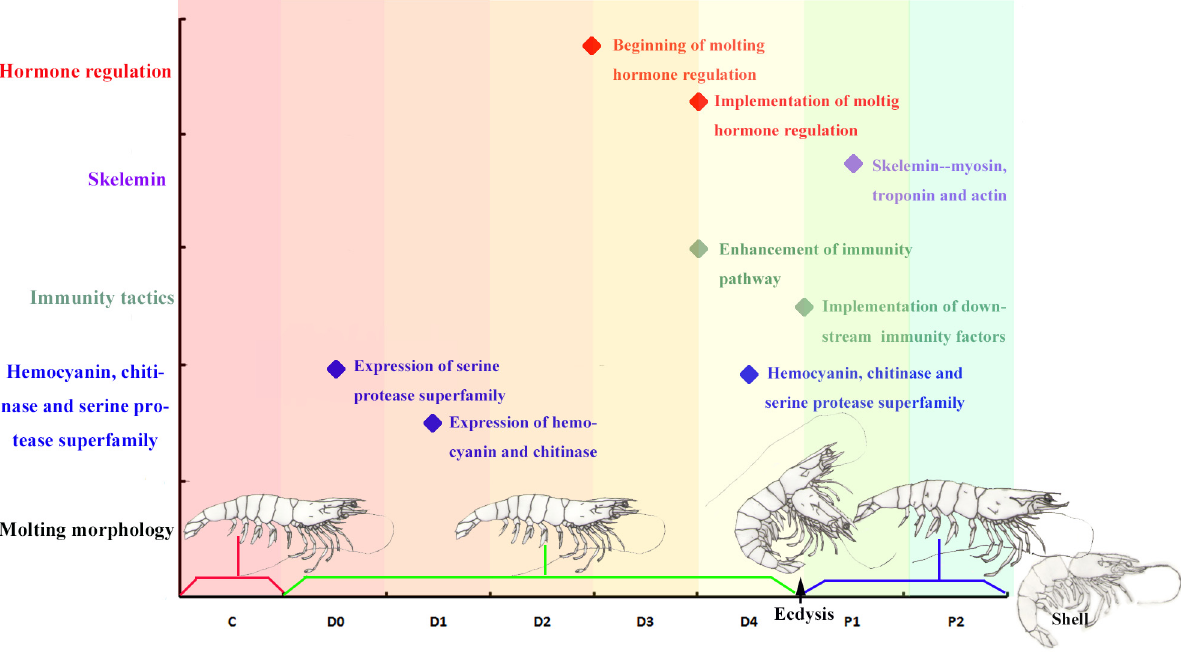
Fig 8. A cascade of molecular events applicable to the molting cycle of L . vannamei . This figure depicts the molecular events identified in this study in relation to the morphological diversification of molting in a diagrammatic sketch. The rhombi represent molecular events occurring in the molting process. The x-axis represents molting